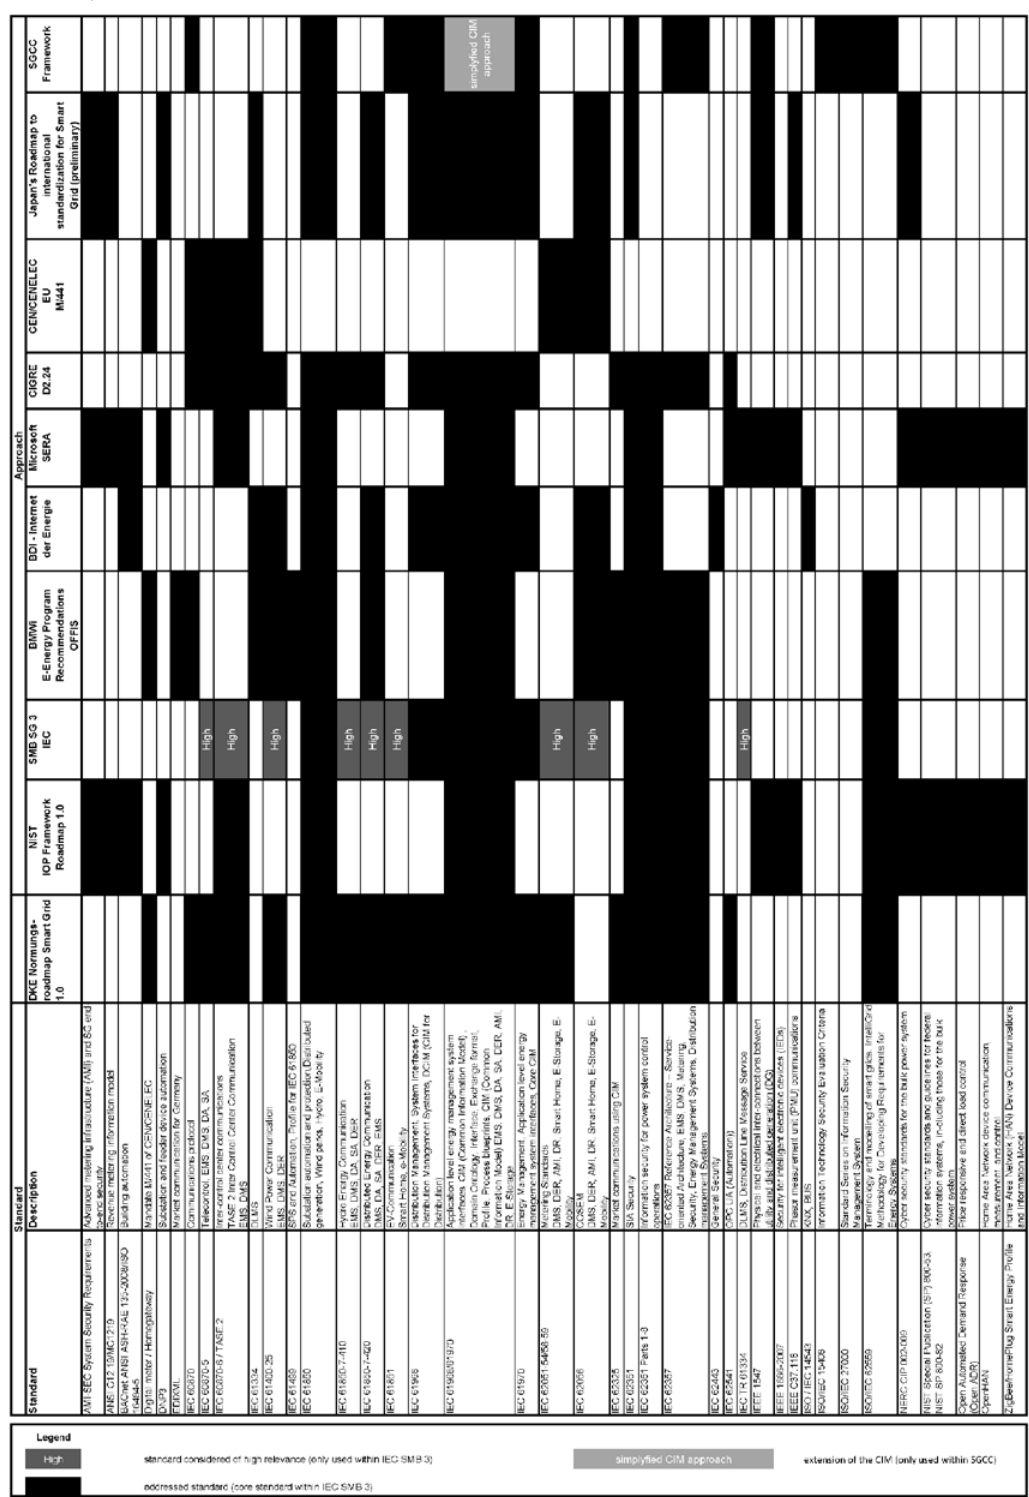
Figure 1 . Overview on standards and related approaches based on [11] and